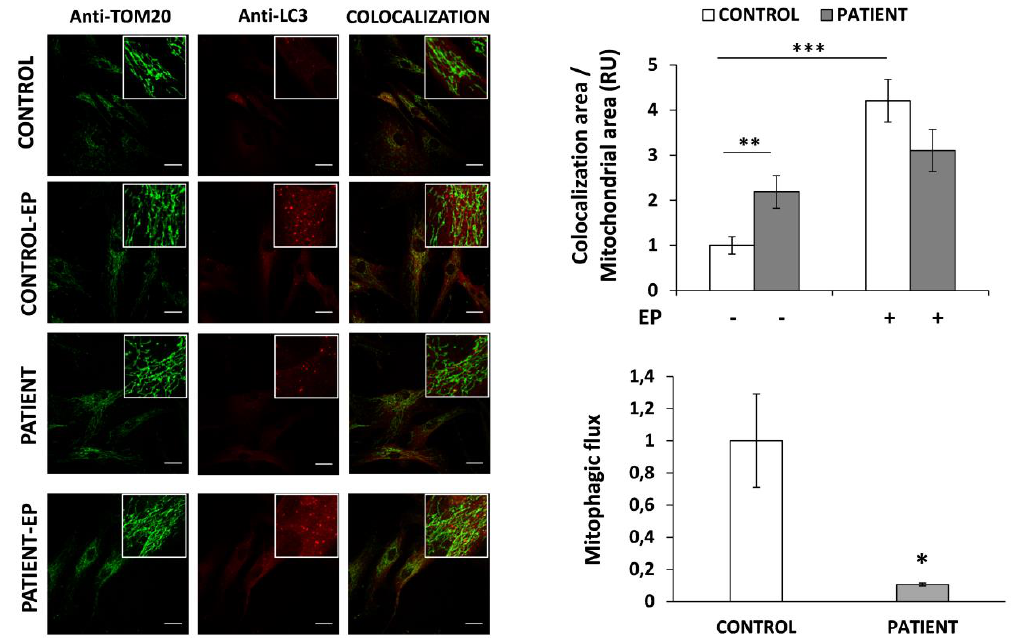
Figure 4. Mitophagy analysis in HACE1 patient fibroblasts. Mitophagv was assessed by immunofluorescence measuring the mitochondria–autophagosome colocalization. Mitochondria was stained with anti-TOM20 and autophagosomes with anti-LC3 antibody. Colocalization was significantly increased in HACE1 fibroblasts compared to control cells. The mitophagic flux, determined as the relative increase in the colocalization area observed after 24 h of EP treatment compared to the basal colocalization, was markedly reduced in HACE1 fibroblasts. In all conditions a minimum of 70 cells were analyzed. Scale bar, 30 µ m. Relative units (RU); E64D-Pepstatine A (EP); * p < 0.05; ** p < 0.01, *** p < 0.001.